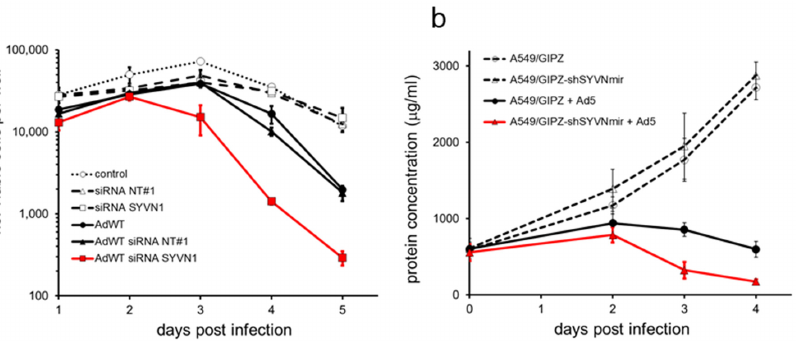
Figure 3. SYVN1 silencing decreases viability of Ad5-infected A549 cells. ( a ) A549 cells were transfected with SYVN1 siRNA or NT#1 siRNA and infected with 100 infectious units (IU)/cell Ad5. Viable cells were counted on days 1 to 5 after infection. Data shown are the mean ± SD of two independent experiments performed in triplicate. ( b ) A549 cells stably transfected with SYVN1-silencing lentiviral vector plasmid GIPZ-shSYVN1mir or with a GIPZ empty vector control plasmid were infected with 100 IU/cell Ad5. Cell viability was determined by BCA protein assay on day 0 and days 2 to 4 after infection. Data shown are the mean ± SD of four independent experiments.